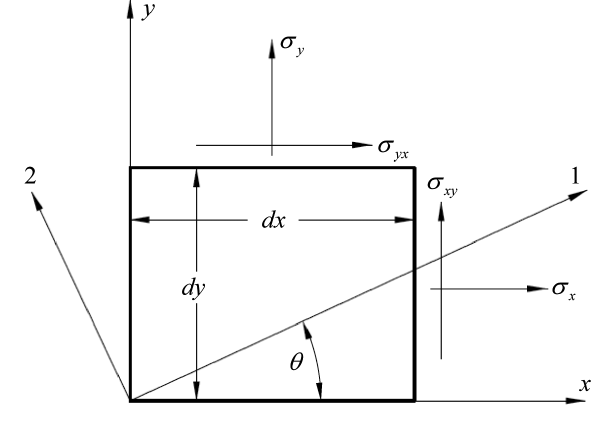
Fig. 3. Lamina coordinate system.